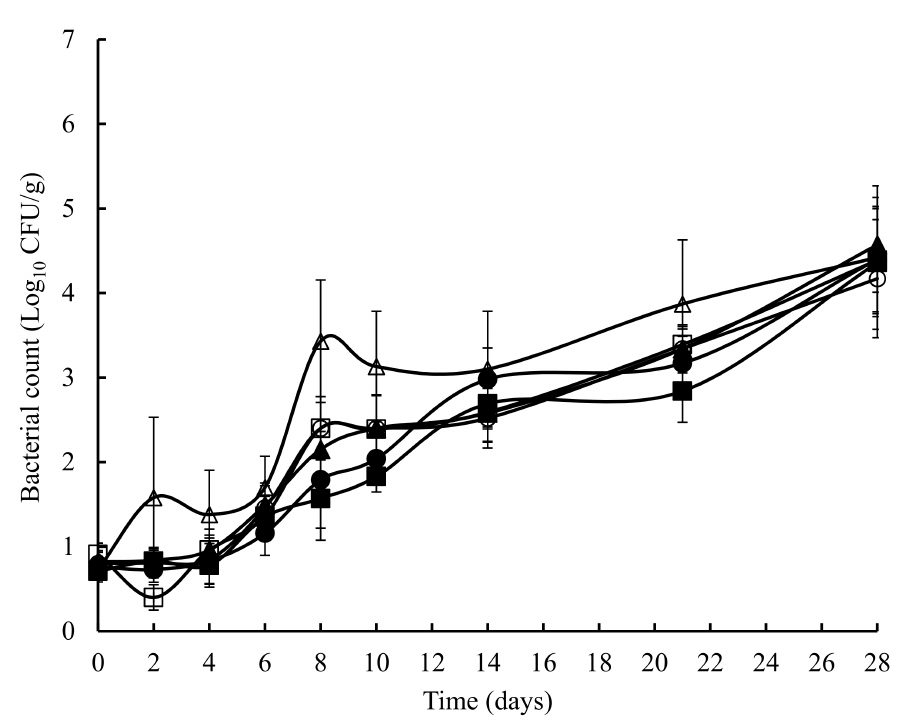
Figure 6. Lactic Acid Bacteria in crab meat samples stored at 4 ◦ C with the following treatments: SDW ( (cid:4) ), Ascorbic Acid ( ), Casein ( (cid:78) ), Casein and Ascorbic Acid ( (cid:3) ), Potato Starch (o), and Potato Starch and Ascorbic Acid ( ∆ ). The error bars represent 1 standard